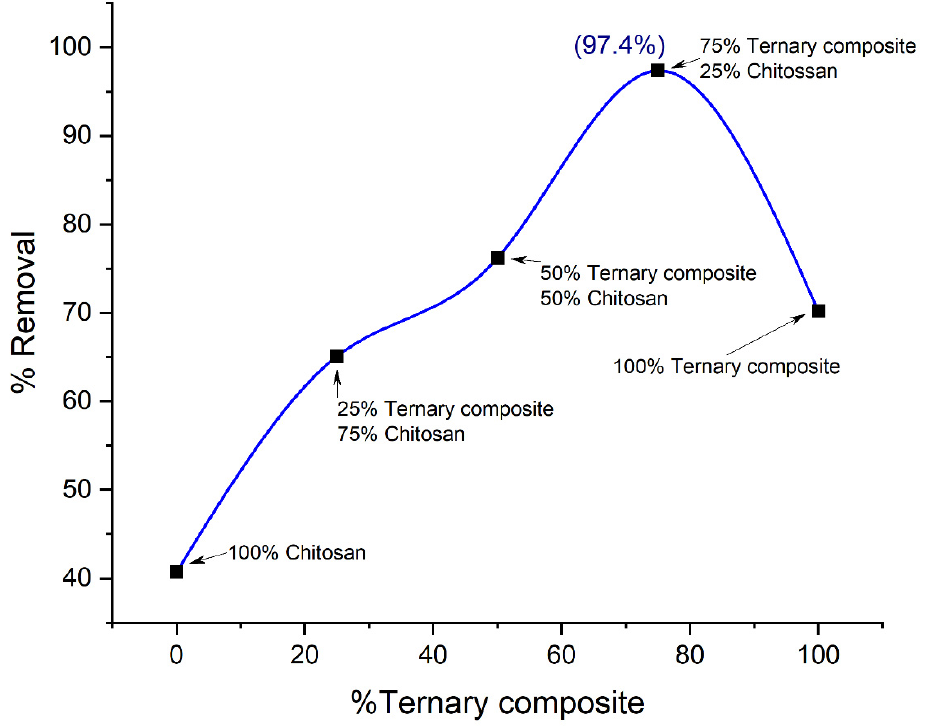
Figure 9. Effect of compositional variation on the removal of Orange G by nanohybrids.